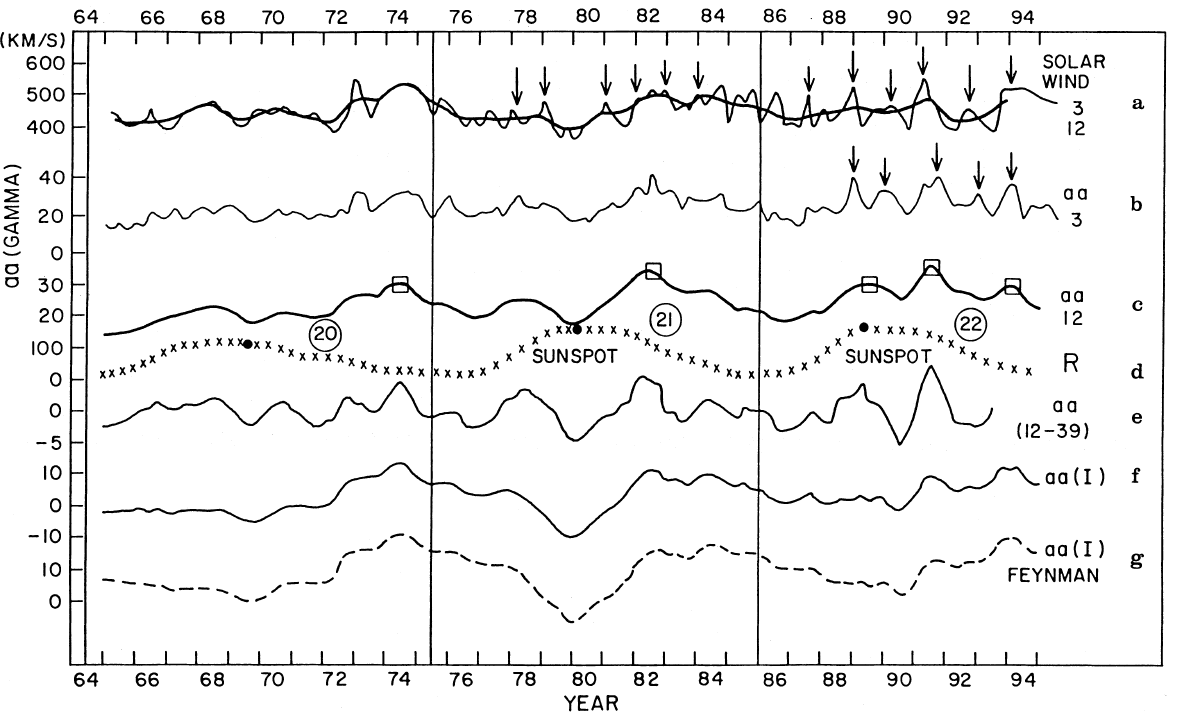
Fig. 7a–g. Plots for 1964–1994, a solar wind at IMP 8, 3-monthly means ( thin lines ) and 12-monthly means ( superposed thick line ), b aa indices 3-monthly means. The arrows in a , b indicate 1.3 year peaks, c